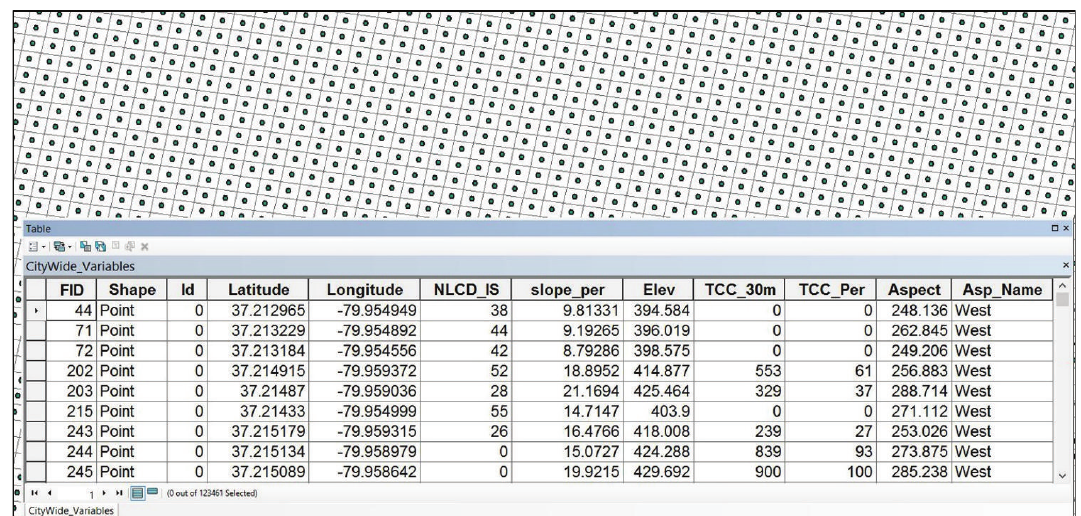
Figure 10: Screenshot of a portion of the GIS attribute table containing landscape variables for each 30 × 30m grid cell for the entire city, illustrating also a portion of the grid.